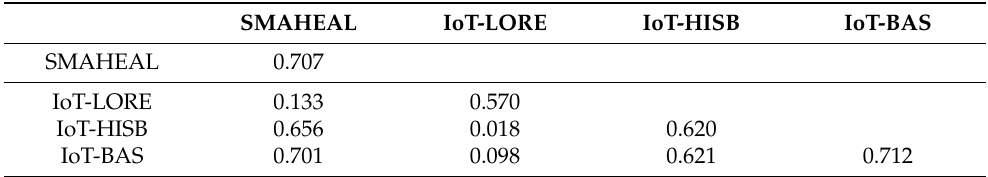
Table 4. Results of discriminant